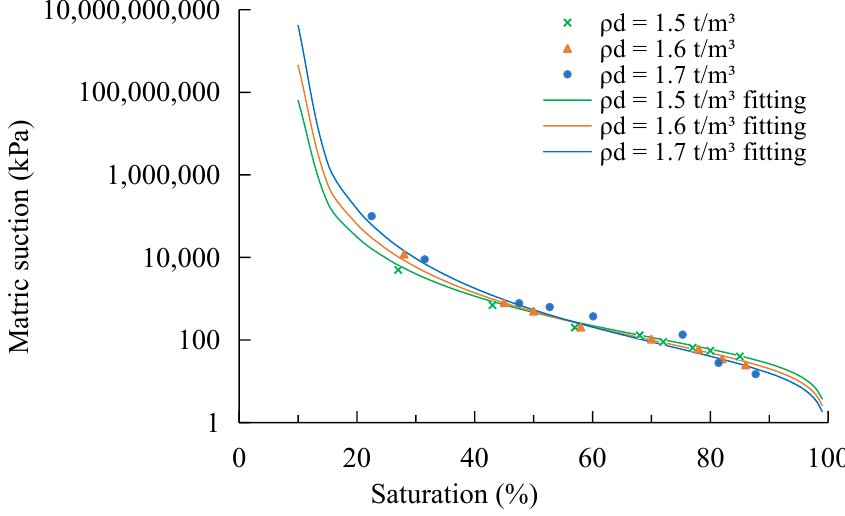
Figure 8. SWCC based on the experimental points and fitted curve at various dry densities.